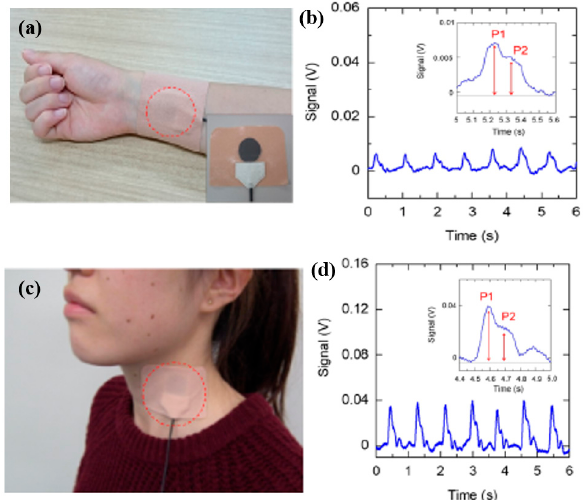
Figure 9. ( a ) Photograph of the as-prepared multifunctional wearable device mounted on the human wrist for simultaneous monitoring of VOC (volatile organic compounds)-related disease and pulse signal; ( b ) normalized resistance changes of the PGF-2 sensor for monitoring wrist pulse and the respiratory rate of a 22-year-old healthy male; ( c ) photograph of a vital sensor attached to the skin of a volunteer using a skin-compatible adhesive patch on the neck; ( d ) real-time monitoring of the pulse [23] (reproduced with permission).